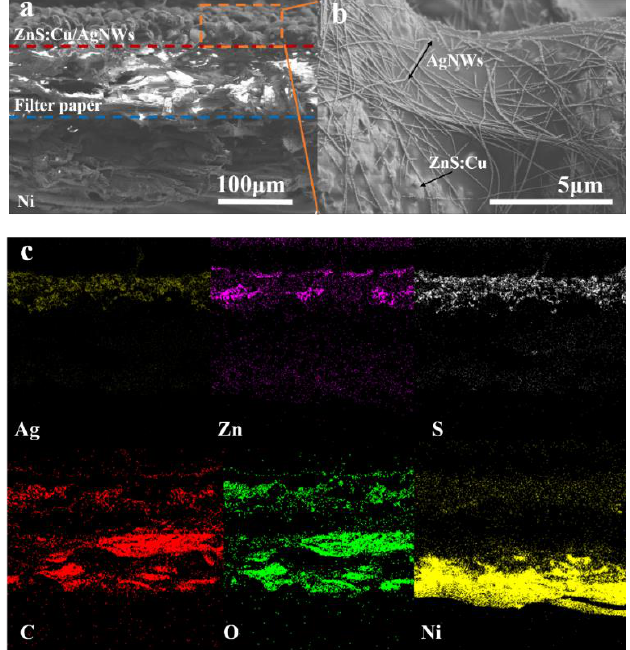
Figure 2. ( a ) Cross-sectional SEM photo of ACEL interface. ( b ) SEM photo of the AgNWs on top. ( c ) Distribution maps of the elements Ag, Zn, S, C, O, and Ni.